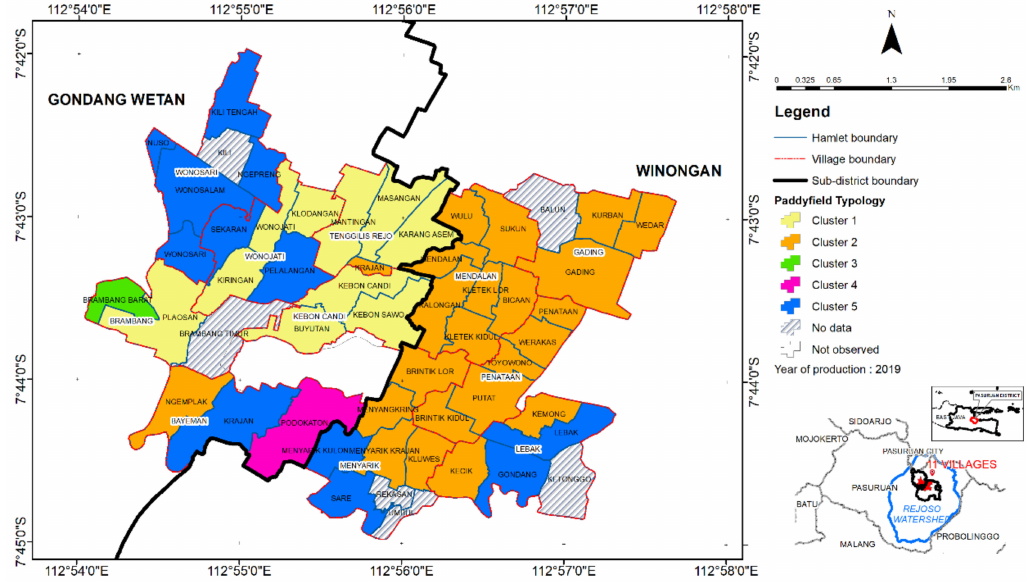
Figure 12. Characteristic of paddy farming in Gondang Wetan and Winongan